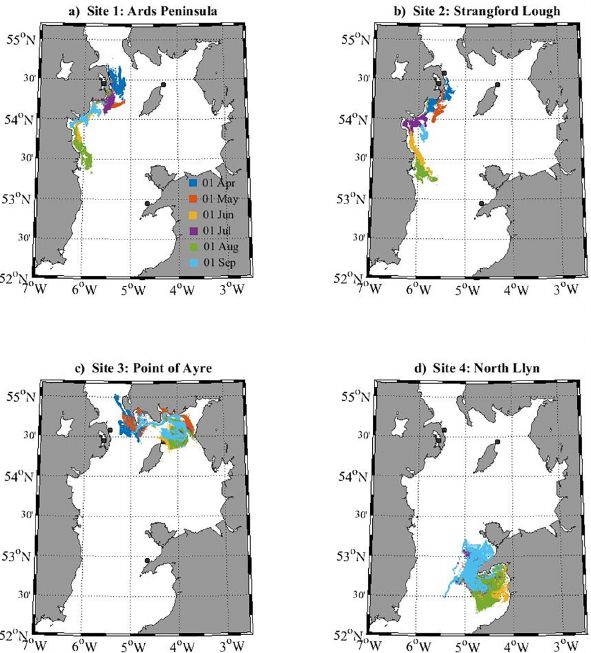
September), released from the distinct source locations (black circles).